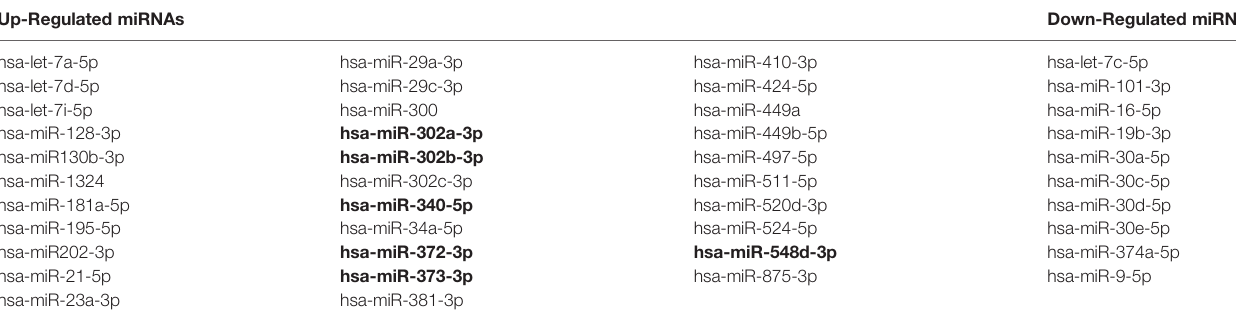
TABLE 1 | miRNAs signi fi cantly expressed in plasma samples of patients with active